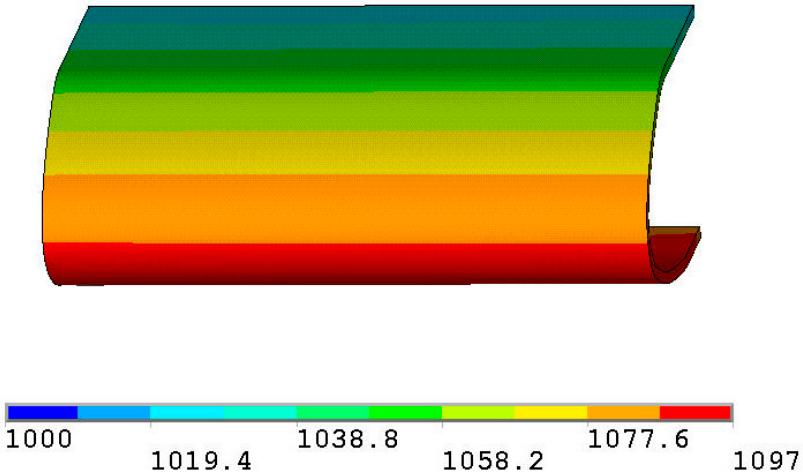
Figure 13. Temperature contour plot at 1200 seconds - Full refined model.